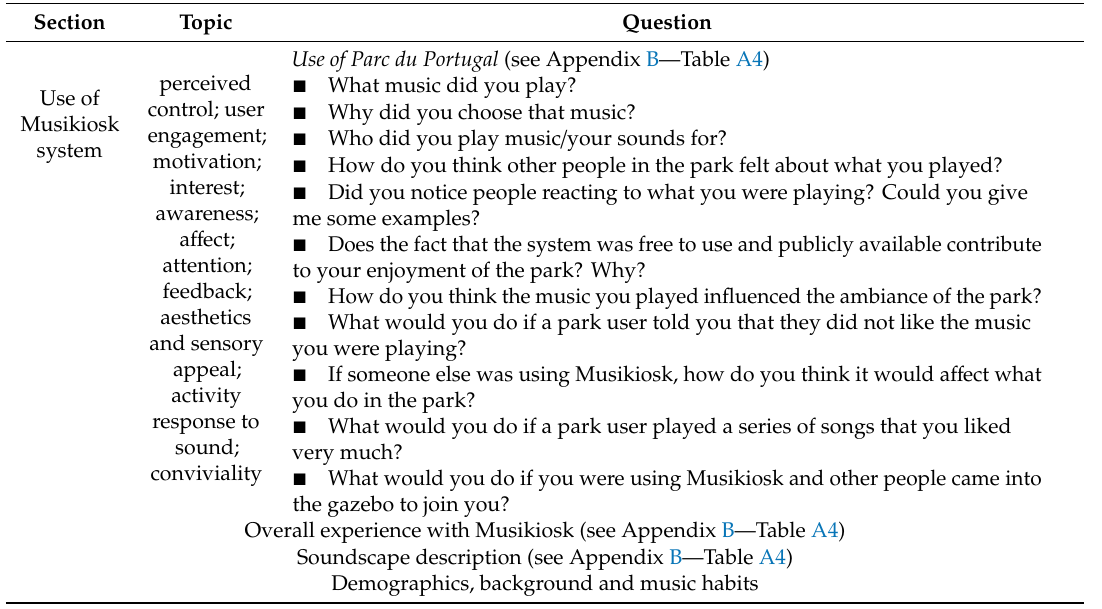
Table A5. Musikiosk user interview